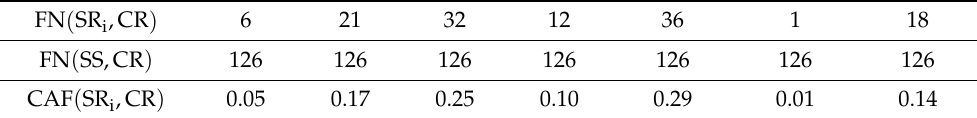
Table 1. Collusion attack frequency.